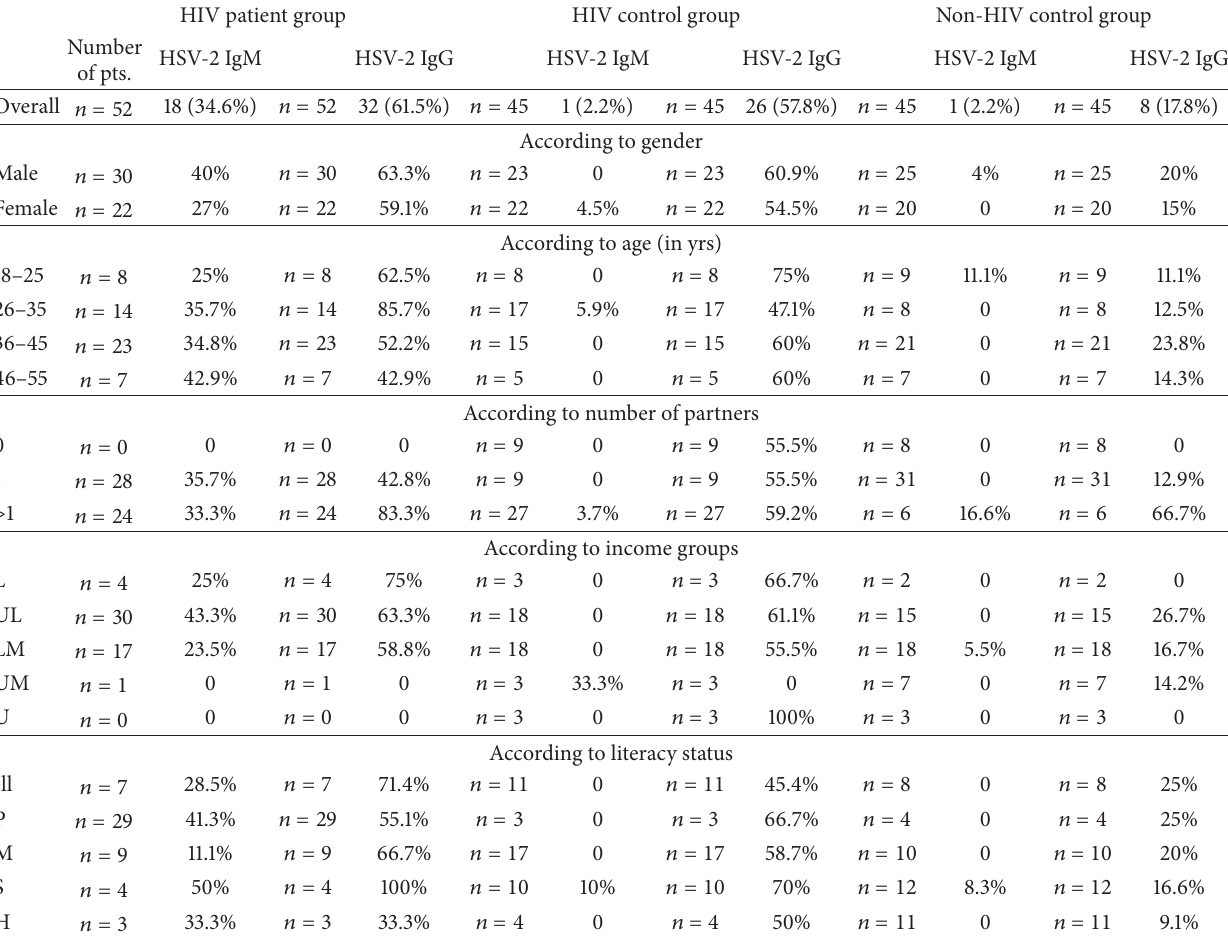
Table 3: Seroprevalence of HSV-2 IgM and HSV-2 IgG antibody.